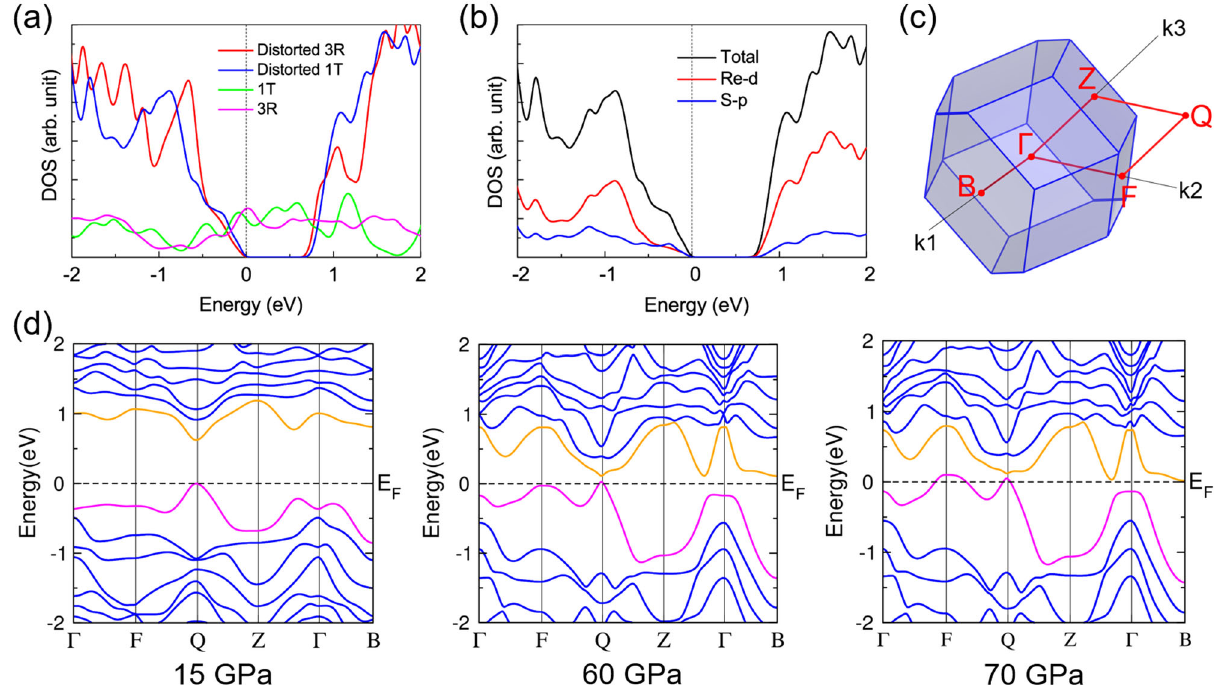
Fig. 3 The electronic band structures and density of states (DOS). a The total electronic DOS of various structures at 15 GPa, which clearly shows that the distortions in distorted-3R and distorted-1T structures introduce bandgaps, which can be attributed to the Peierls mechanism. c The fi rst Brillion zone and d the calculated band b The total and partial DOS for the distorted-1T ReS 2 at 15 GPa. The Fermi level is set to zero. structures of the distorted-1T ReS 2 at several pressures. The distorted-1T undergoes a metallization transition with a band overlap mechanism upon